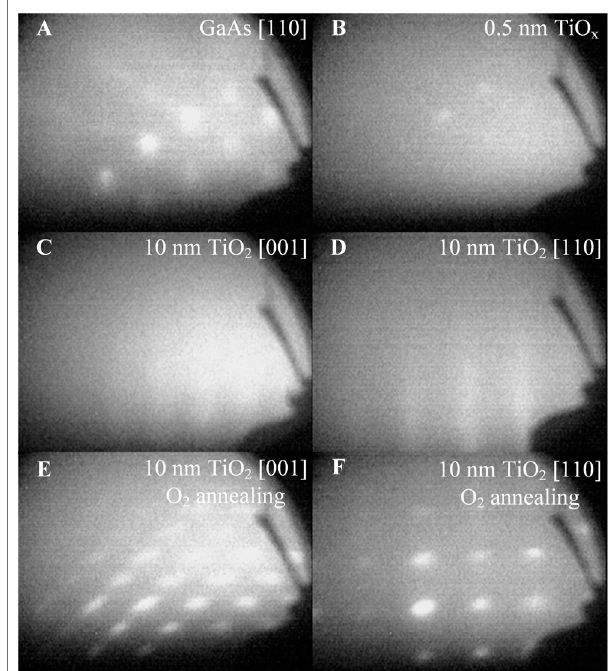
FIGURE1| RHEEDpatternsof (A) cleanedGaAssurfacealongthe[110] azimuths; (B) 0.5 nm-TiO 2 ; and (C) 10-nm TiO 2 along the [001] azimuths; (D) 10-nmTiO 2 alongthe[110]azimuths; (E) 10-nmTiO 2 alongthe[001]azimuths after annealing; and (F) 10-nm TiO 2 along the [110] azimuths after